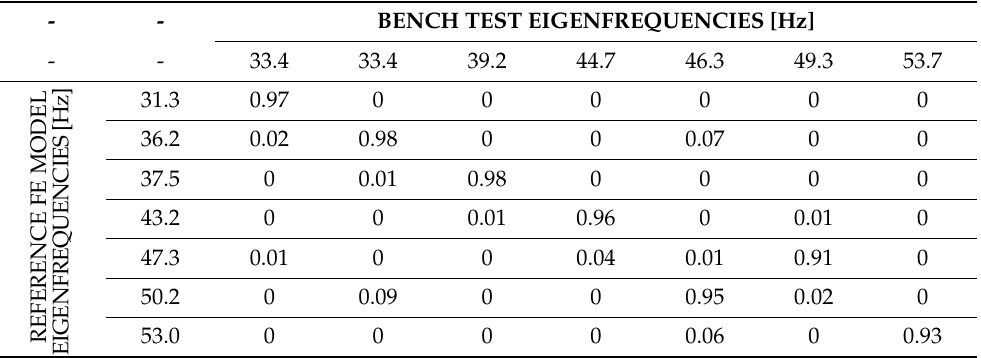
Table 2. MAC results for the reference FE vehicle body structure